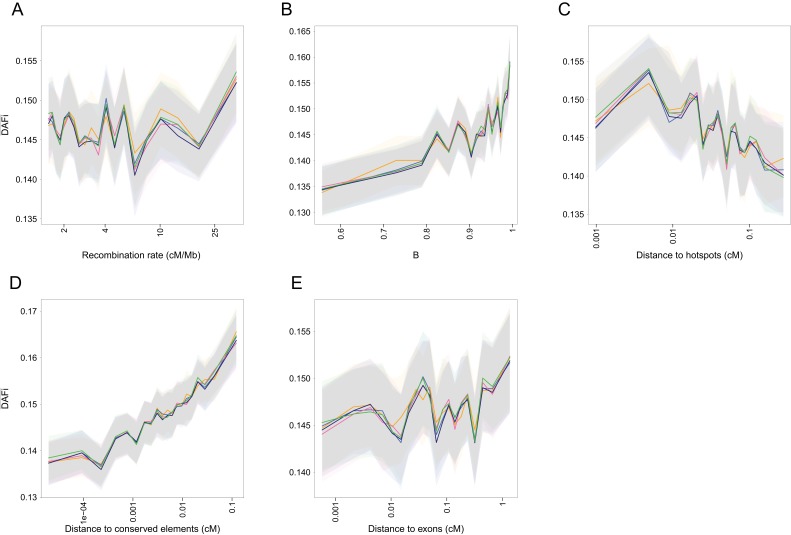
DAFi¯ of WW + SS sites with RR ≥1.5 cM/Mb from the 1000G data set as a function of various covariates.(A) recombination rate, (B) B statistic, (C) recombination distance to hotspots that are defined as having RR >10 cM/Mb, (D) distance to PhastCons conserved elements and (E) distance to exons. DAFi¯ is positively correlated with the distance to conserved elements and to a smaller extent to B and the distance to exons, whereas it is negatively correlated to the distance to hotspots which suggest that BGS continues to play a marginal role on DAFi¯. SNPs were divided into 20 bins of equal size. Shaded areas correspond to 95% CI obtained by a block-bootstrap approach (see Materials and methods).